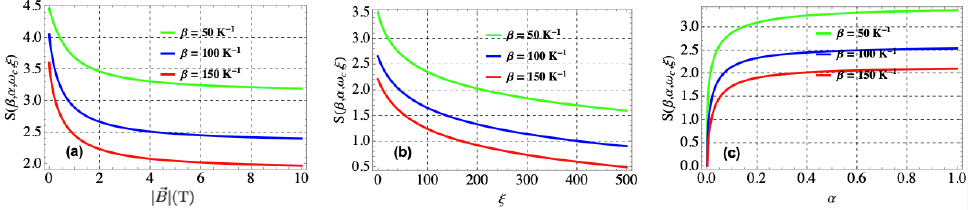
Figure 3. Plot of entropy S ( β ) as a function of | (cid:126) B | ( T ) ( a ), ξ ( b ) and α ( c ) for different values of β = 50 k − 1 (green curve), 100 k − 1 (blue curve) and 150 k − 1 (red curve); all other parameters are the same as in Figure 1.